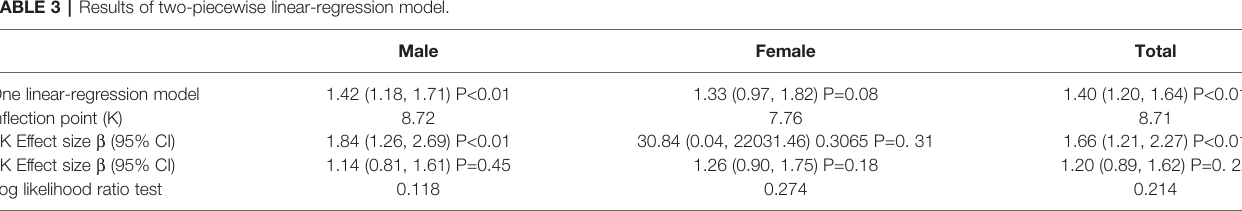
TABLE 3 | Results of two-piecewise linear-regression model.